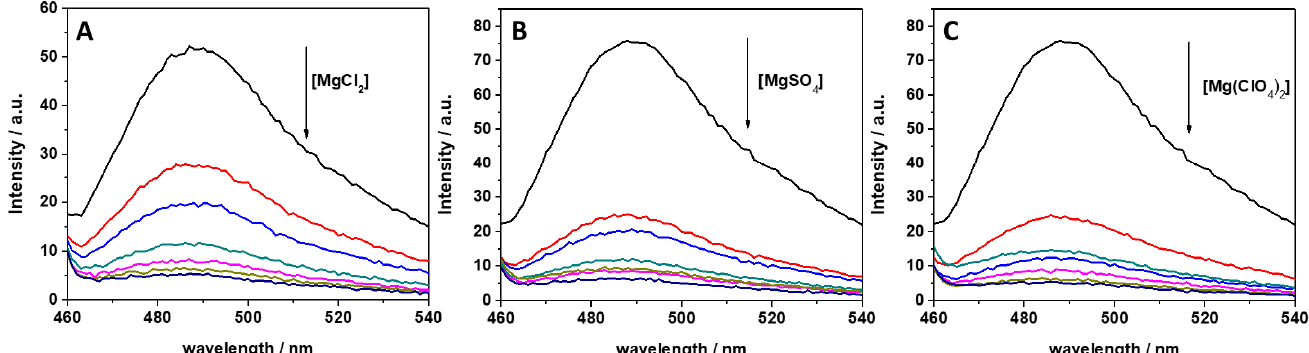
Figure 1. Fluorescence emission spectra of a 0.5 μ M ThT solution, mixed with 100 μ M of tRNA from E. coli in the presence of ( A ) MgCl 2 , ( B ) MgSO 4 , and ( C ) Mg(ClO 4 ) 2 . The arrows indicate the direction of increasing concentration of the magnesium salt. Color code: black (0 mM Mg salt), red (0.5 mM Mg salt), blue (1 mM Mg salt), dark cyan (2 mM Mg salt), magenta (5 mM Mg salt), dark yellow (10 mM Mg salt), and navy (20 mM Mg salt). All the spectra were acquired in 20 mM Tris-HCl buffer, 40 mM KCl, pH 6.9, at the temperature of 25 °C and pressure of 1 bar. The intensity is reported in arbitrary units (a.u.).